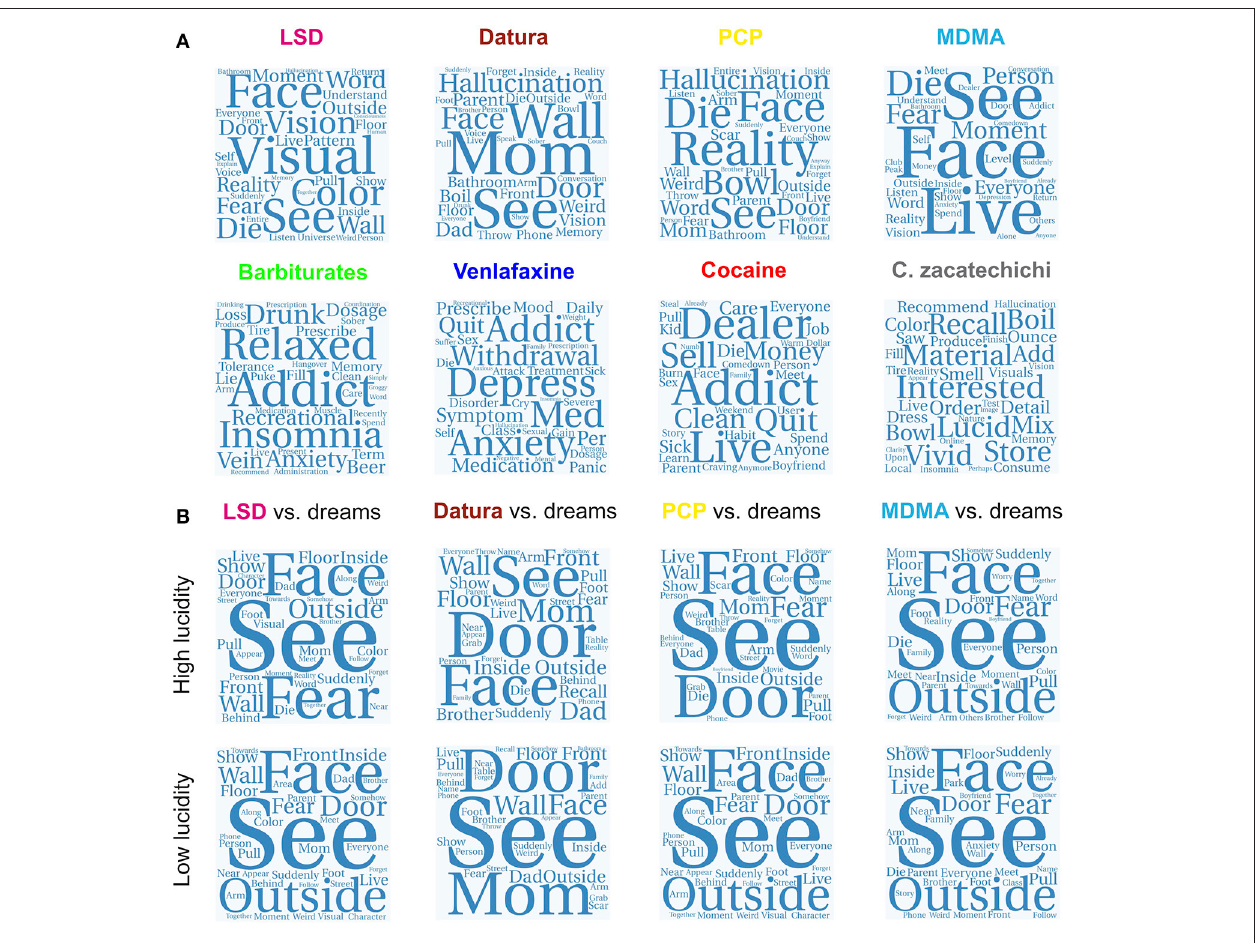
FIGURE 7 | Word clouds for the top 40 most frequent terms in the reports of four substances with high similarity to dream reports (LSD, plants of the Datura genus, PCP and MDMA) and in the reports of four substances with lower similarity to dream reports (barbiturates, venlafaxine, cocaine, and Calea zacatechichi ) (A) . (B) shows word clouds based on the average ranking of each term in the reports of the four psychoactive substances of (A) and in the reports of high/low lucidity